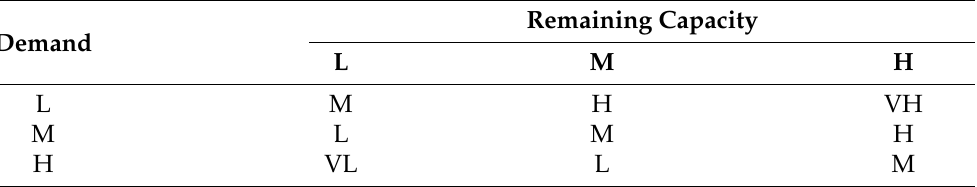
Table 1. The rules used in the Fuzzy system for the VRP.